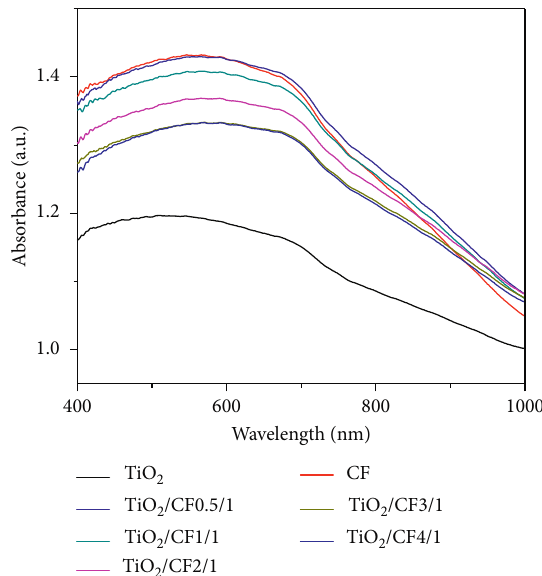
Figure 3: UV-vis absorbance spectra of TiO prepared TiO 2 /CF composites.